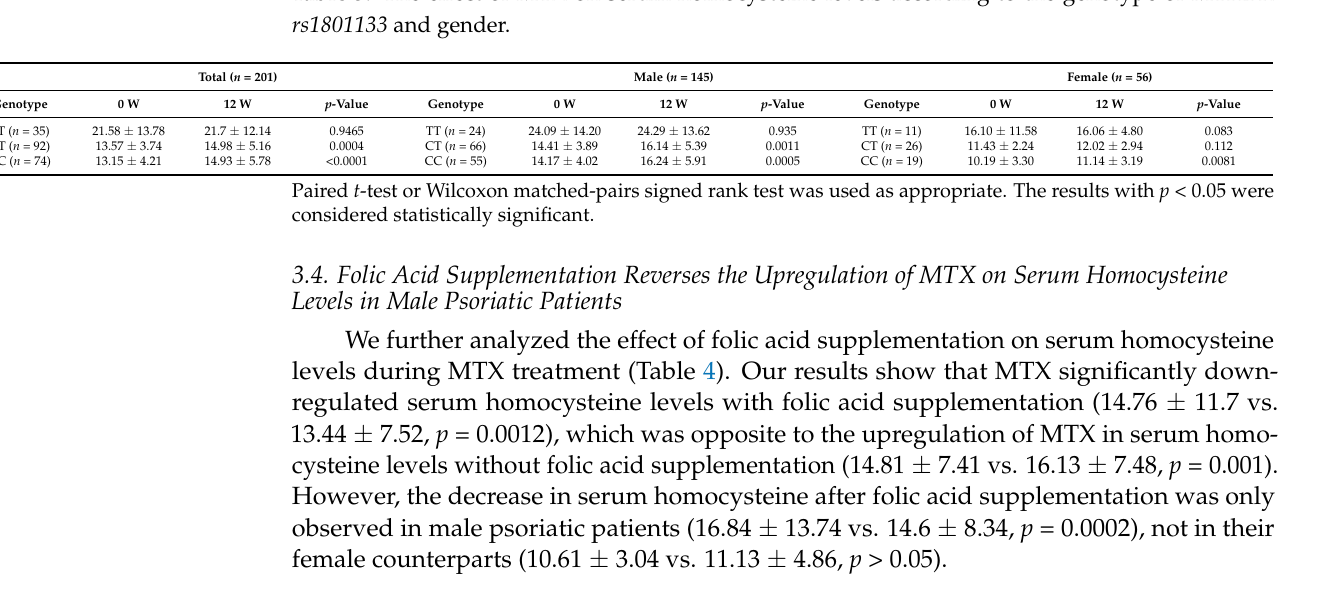
Table 4. The effect of MTX on serum homocysteine levels according to gender and folate